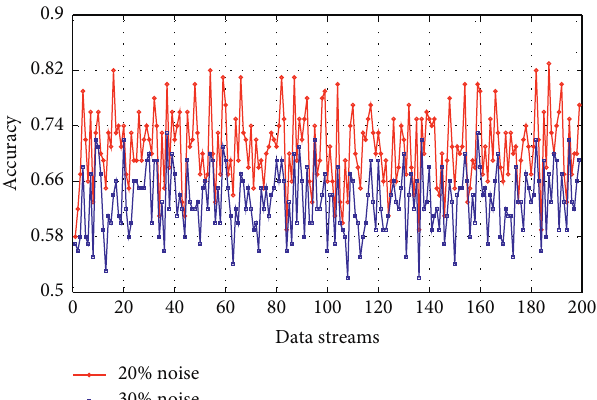
Figure 6: The accuracy curve for the MCBIE method with SEA data stream.